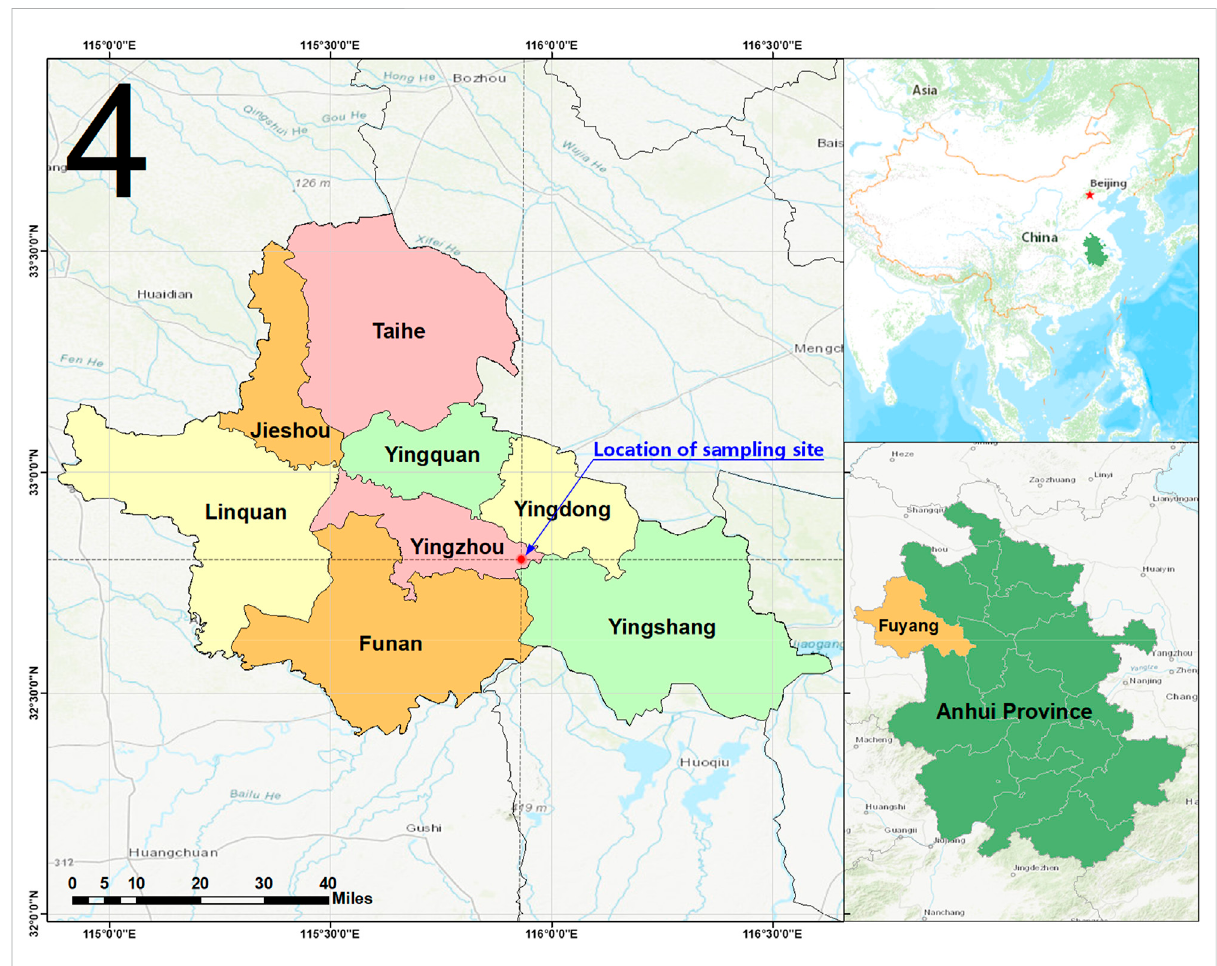
FIGURE 1 Location map of Fuyang (Xiaoguozhuang, Yuanji Town, Yingzhou District, Fuyang City, Anhui